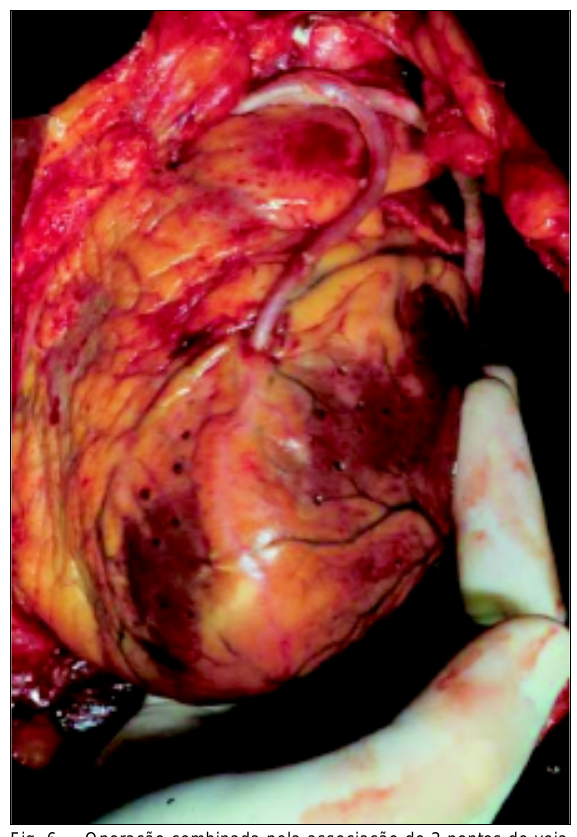
Fig. 6 - Operação combinada pela associação de 2 pontes de veia safena e canais realizados pelo LASER de CO 2 na parede anterior e lateral do